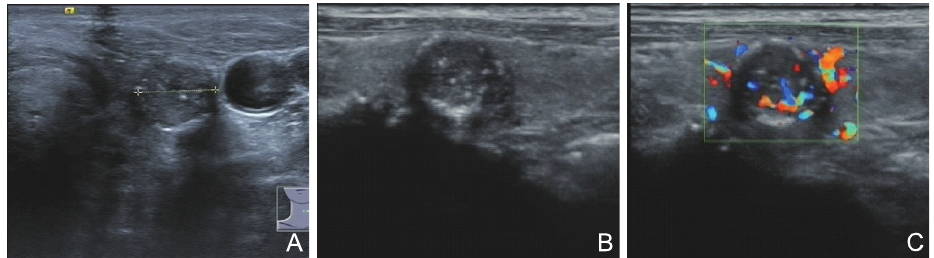
Figure 1 The ultrasound features of the left thyroid nodule before FNAB showed it was round, solid, and heterogeneous with discontinuous rim calcification in transverse (A) and vertical section (B). Color Doppler Flow Imaging (CDFI) revealed marked blood flow inside and around the nodule (C).